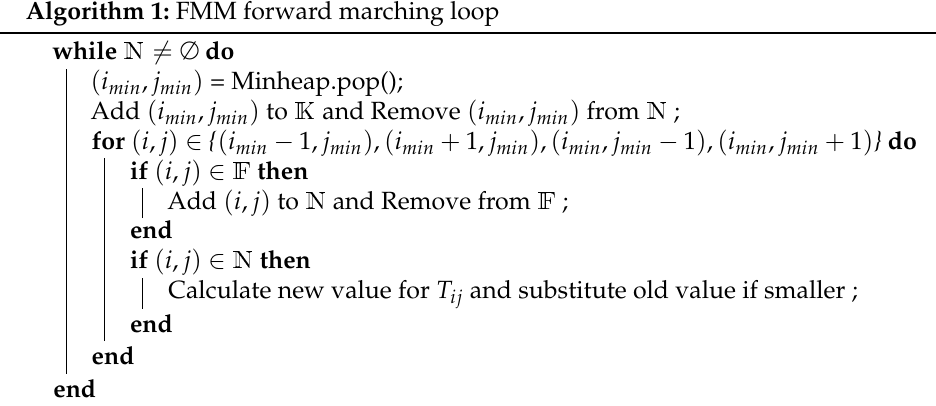
Algorithm 1: FMM forward marching